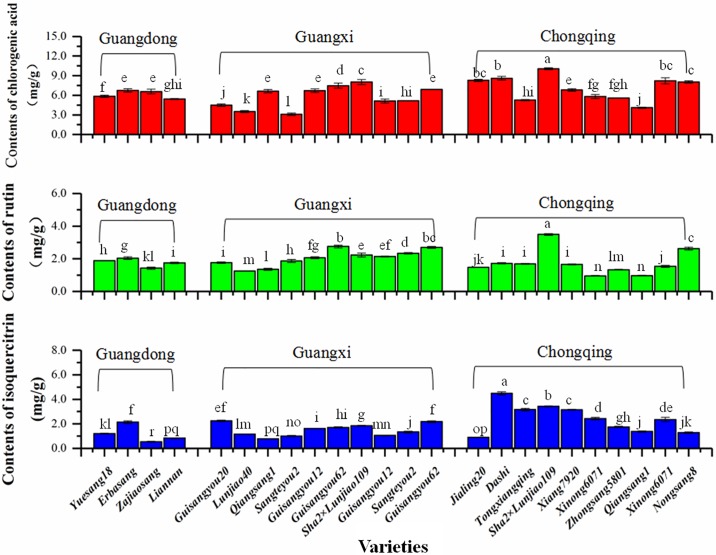
Contents of phenols from different collection areas.(TIF) The red columns mean the contents of chlorogenic acid from different collection areas, the green columns mean the contents of rutin and the blue columns mean the contents of isoquercitr.